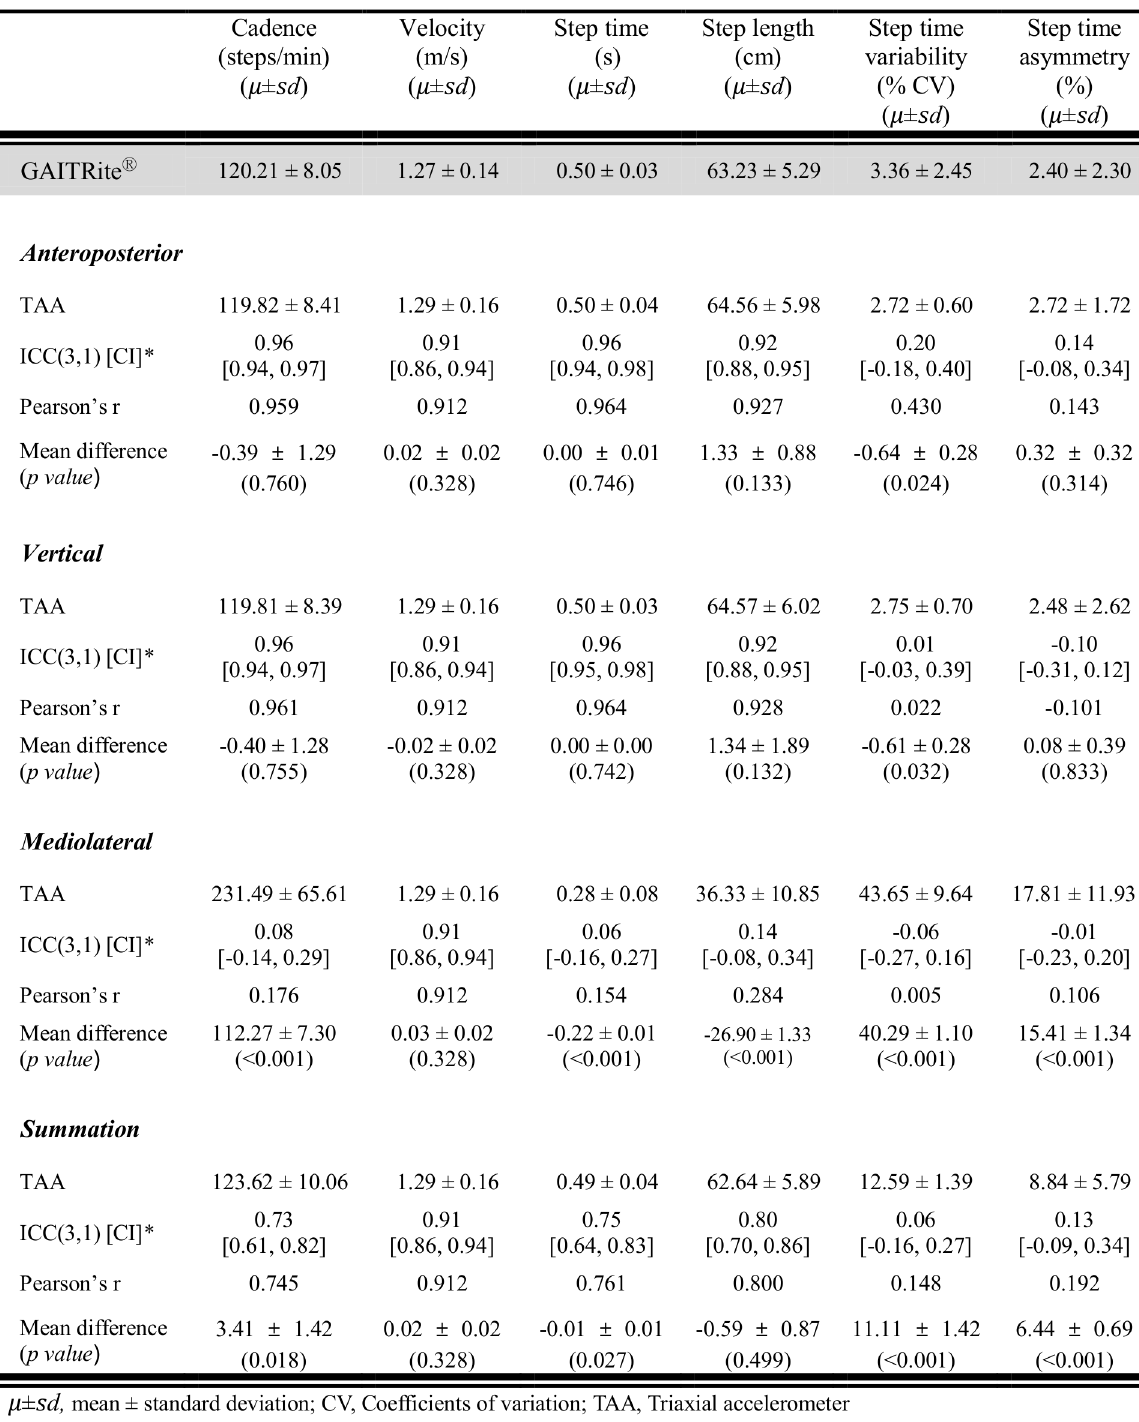
Fig 4. Level of agreement between a triaxial accelerometer and GAITRite 1 for spatiotemporal gait parameters.